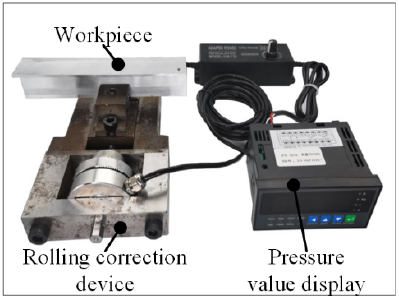
Figure 2. Rolling correction processing of structural parts.